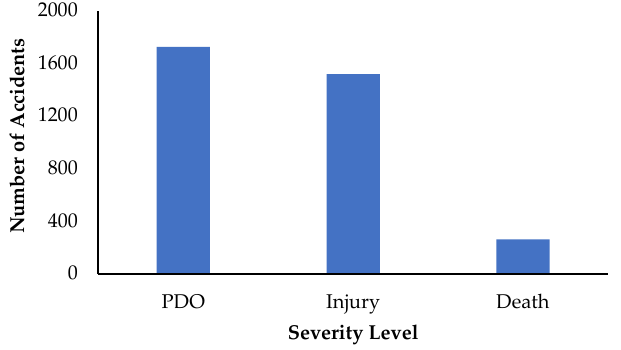
Figure 3. Number of accidents under each injury severity classification for highway crashes in Qassim Region between January 2017 and December 2019.